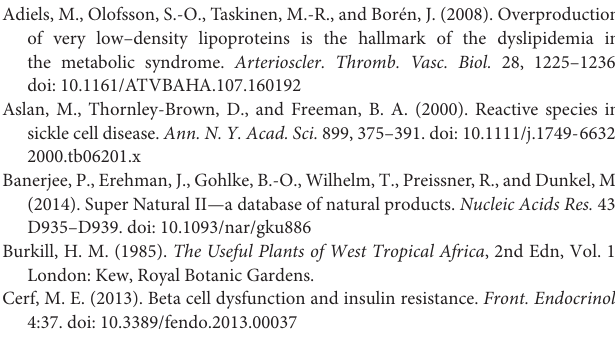
FIGURE S1 | Acute effects of crude extract (MeOH), dichloromethane fraction (DCM), butanol fraction (BuOH) and aqueous fraction (aqueous) on blood glucose of diabetic rats. Values are means ± SD ( n = 5). Control: non-diabetic control rats; Db: diabetic rats treated with saline only; Crude-200 mg/kg, and Crude-400 mg/kg: diabetic rats treated with MeOH extract of 200 and 400 mg/kg bw; DCM-200 mg/kg, and DCM-400 mg/kg: diabetic rats treated with DCM fraction of 200 and 400 mg/kg; BuOH-200 mg/kg, and BuOH-400 mg/kg: diabetic rats treated with BuOH fraction of 200 and 400 mg/kg bw; aqueous-200 mg/kg, and aqueous-400 mg/kg: diabetic rats treated with aqueous fraction of 200 and 400 mg/kg bw; GB-5mg/kg: diabetic rats treated with glibenclamide 5 mg/kg bw. ∗ p < 0.05, ∗∗ p < 0.01, ∗∗∗ p < 0.001, compared to their respective 0-h values. FIGURE S2 | (A) Binding orientation and interaction of the original ligand lisinopril (in magenta) and the docked compounds 5,7,4 (cid:48) -trimethoxykaempferol (in blue) and Biochanin (in orange) into the active site of the ACE enzyme. (B) Ligand–protein interaction diagram: 5,7,4 (cid:48) -trimethoxykaempferol (Left) and Biochanin (Right) interacts with the protein ACE, respectively, via hydrogen bonds (shown in blue arrow) and π interactions (shown as orange lines) with the participating π systems and hydrophobic contacts. FIGURE S3 | (A) Binding orientation and interaction of the original ligand acarbose (in magenta) and the docked compounds 5,7,4 (cid:48) -trimethoxykaempferol (in blue) and Biochanin (in orange) into the active site of the Human Maltase-Glucoamylase enzyme. (B) Ligand–protein interaction diagram: 5,7,4 (cid:48) -trimethoxykaempferol (Left) and Biochanin (Right) interacts with the protein Human Maltase-Glucoamylase, respectively, via hydrogen bonds (shown in blue arrow) and π interactions (shown as orange lines) with the participating π systems and hydrophobic